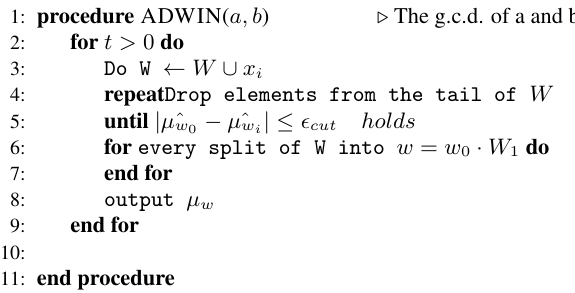
Algorithm 1 Adaptive Windowing Algorithm